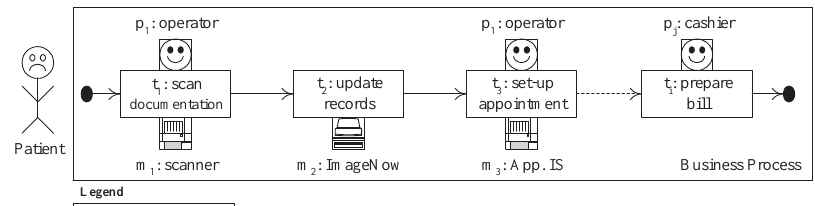
Figure 1. Business process’s